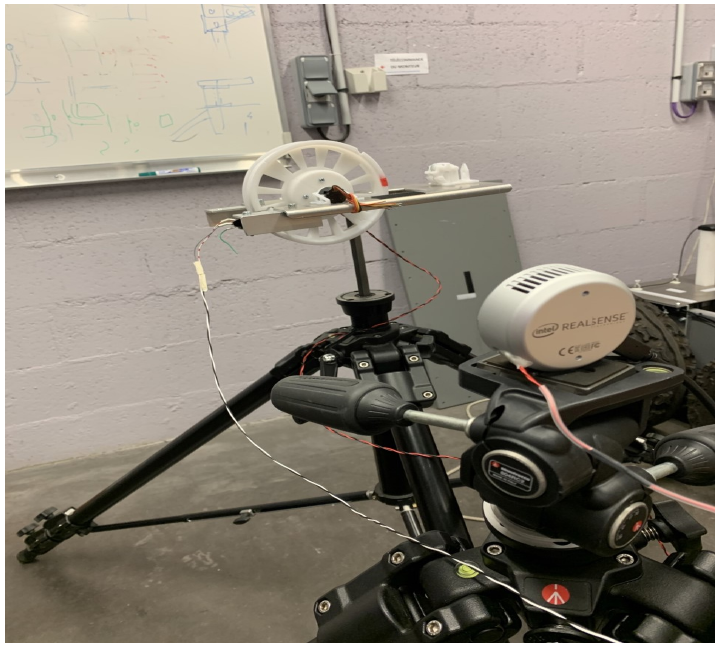
Figure 8. Protocol of validation of the synchronization of the camera and LiDAR